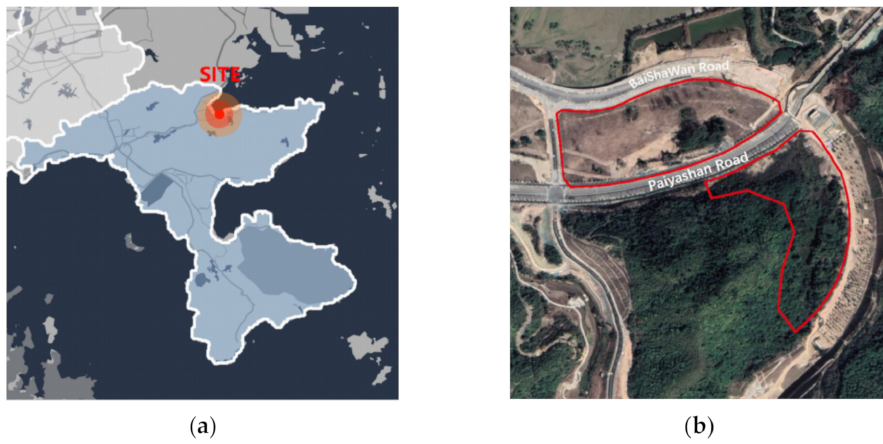
Figure 2. Geographical location diagram: ( a ) Location diagram; ( b ) Status